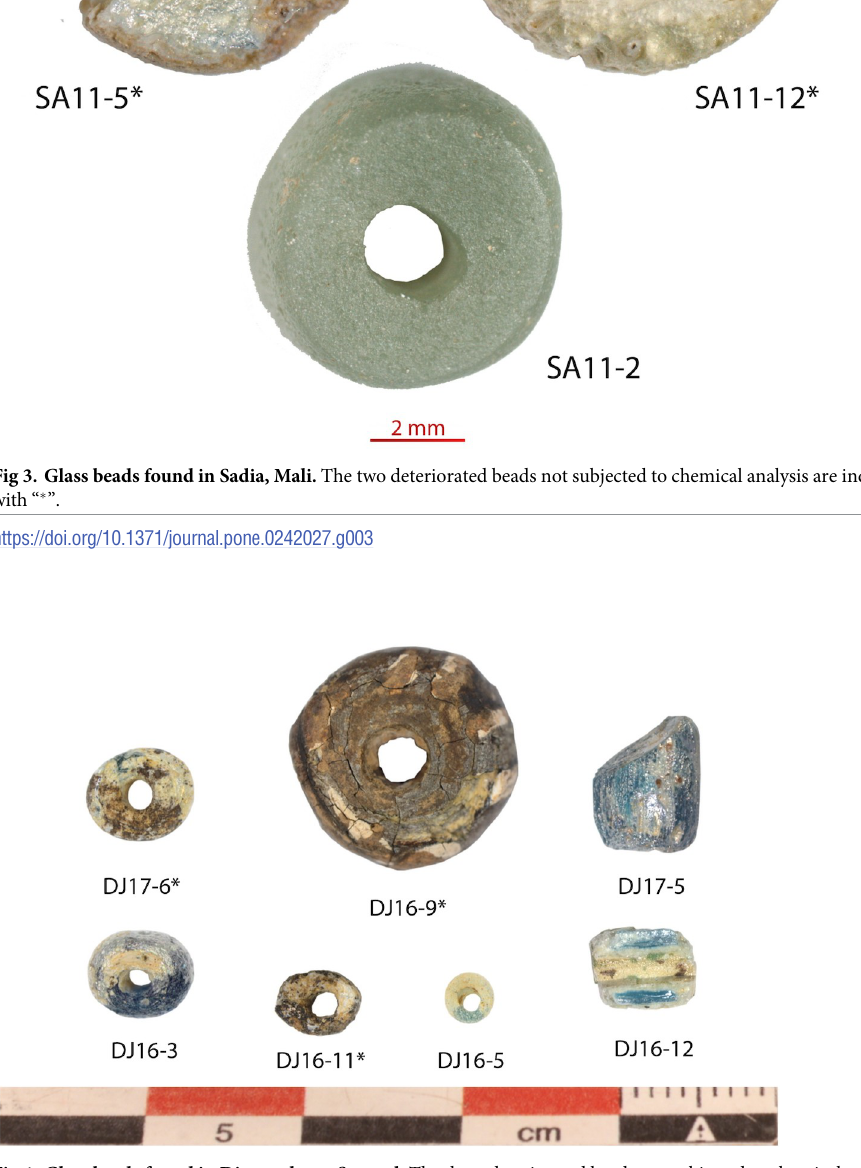
PLOS ONE | https://doi.org/10.1371/journal.pone.0242027 December2,